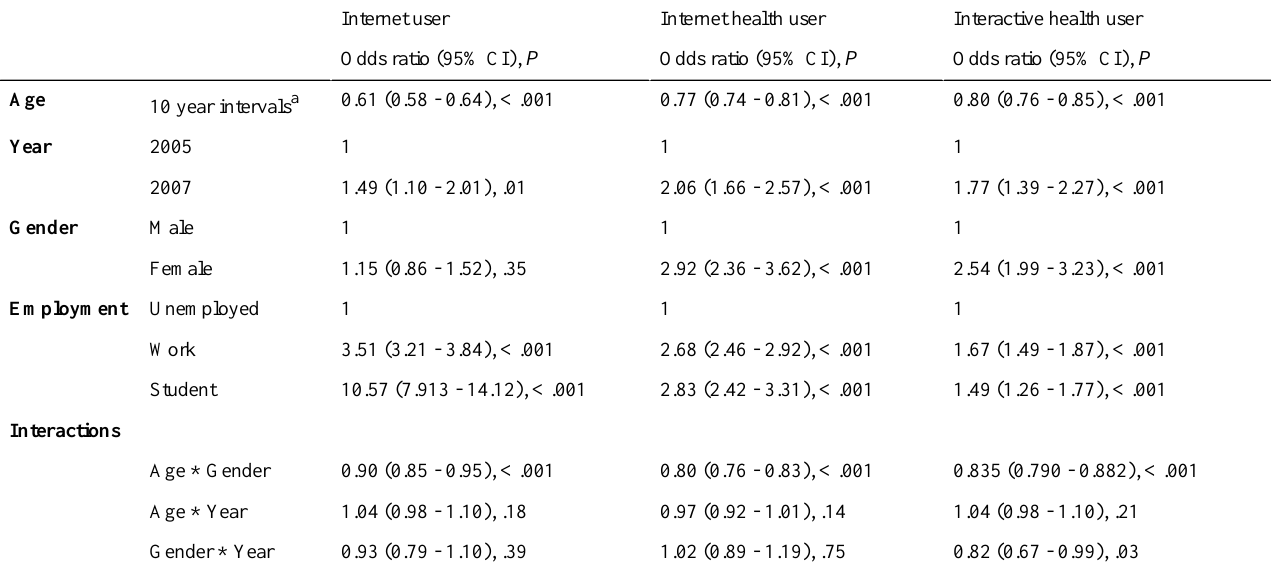
Table 4. Factors affecting Internet usage, Internet health usage, and the use of interactive health services. Sample is based on all respondents in all seven countries (N =